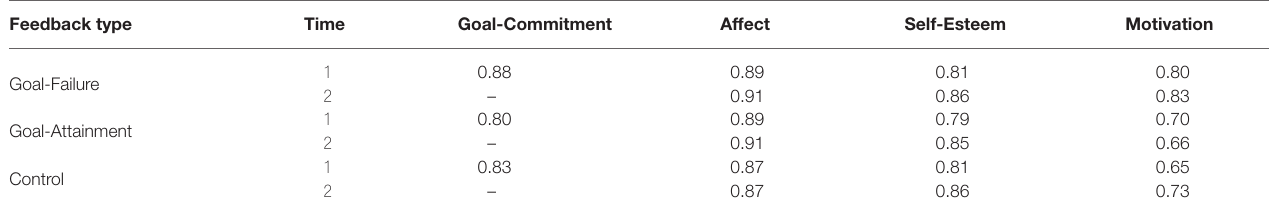
TABLE 2 | Cronbach’s α for feedback type conditions and measurement